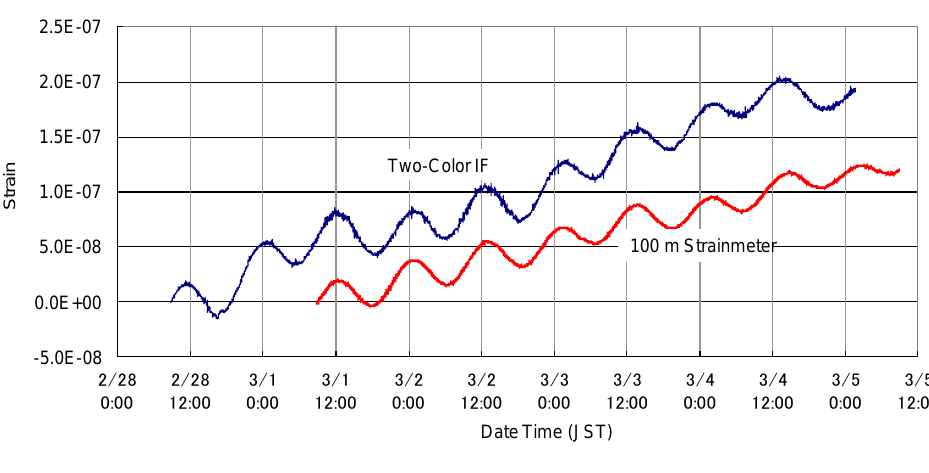
Figure 6. Strain data observed by the two-color interferometer and the 100 m strainmeter. Changes in strain due to the earth tides were clearly recorded. And changes in strain caused by small earthquakes were also recorded by two-color interferometer because of its high sampling frequency of 3.8 Hz. The high frequency components are not visible in the curve of 100 m strainmeter record because it is taken by averaging in 1 min